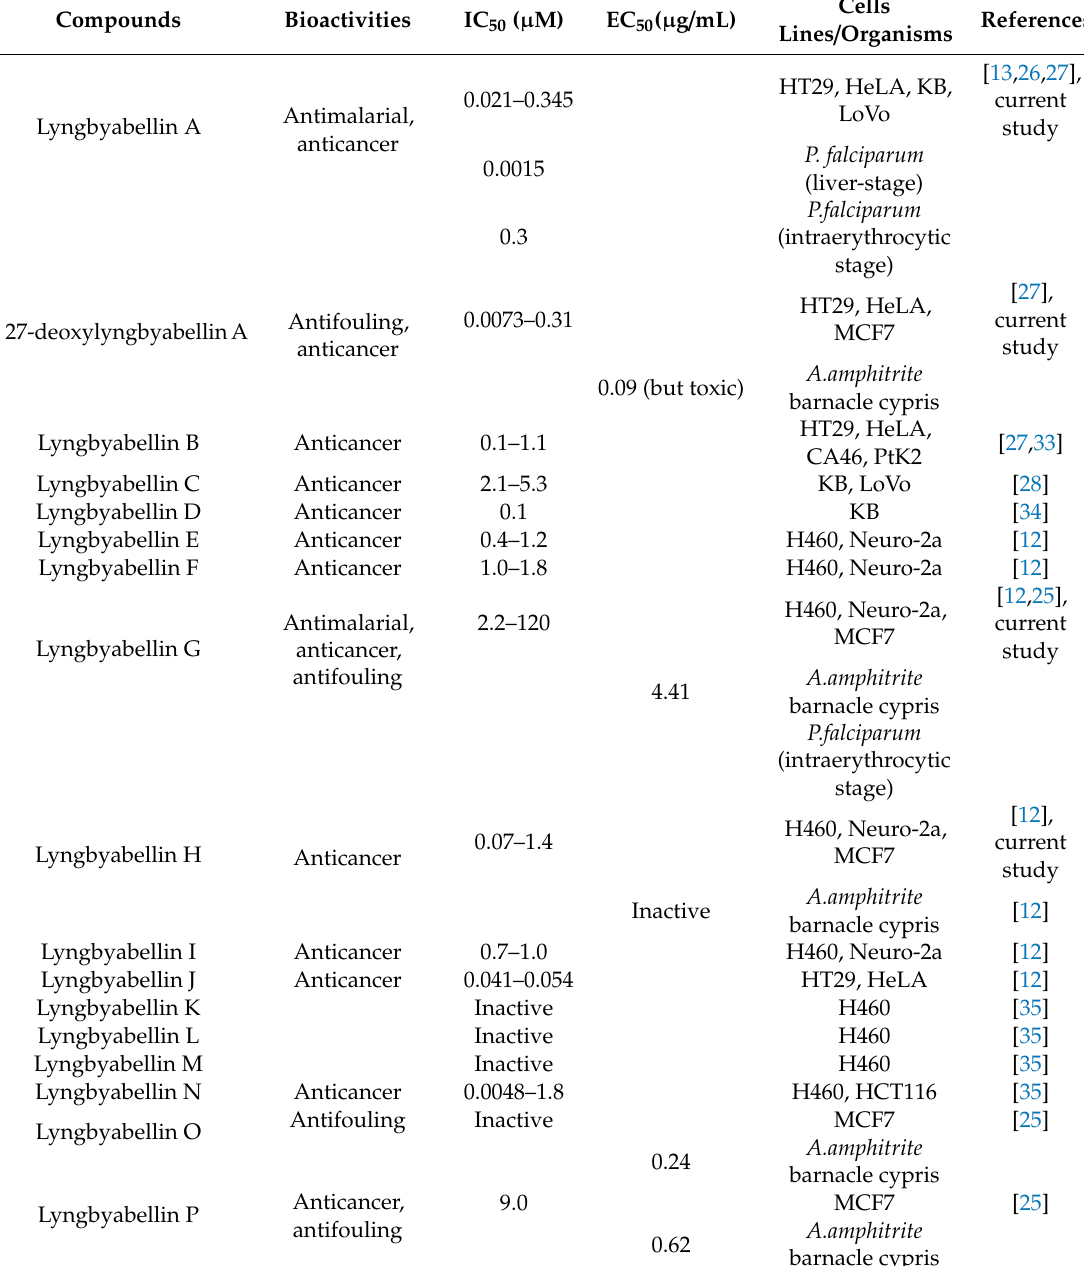
Table 2. Diversity of biological activities reported for Lyngbyabellins in the literature from 2000 to 2020.